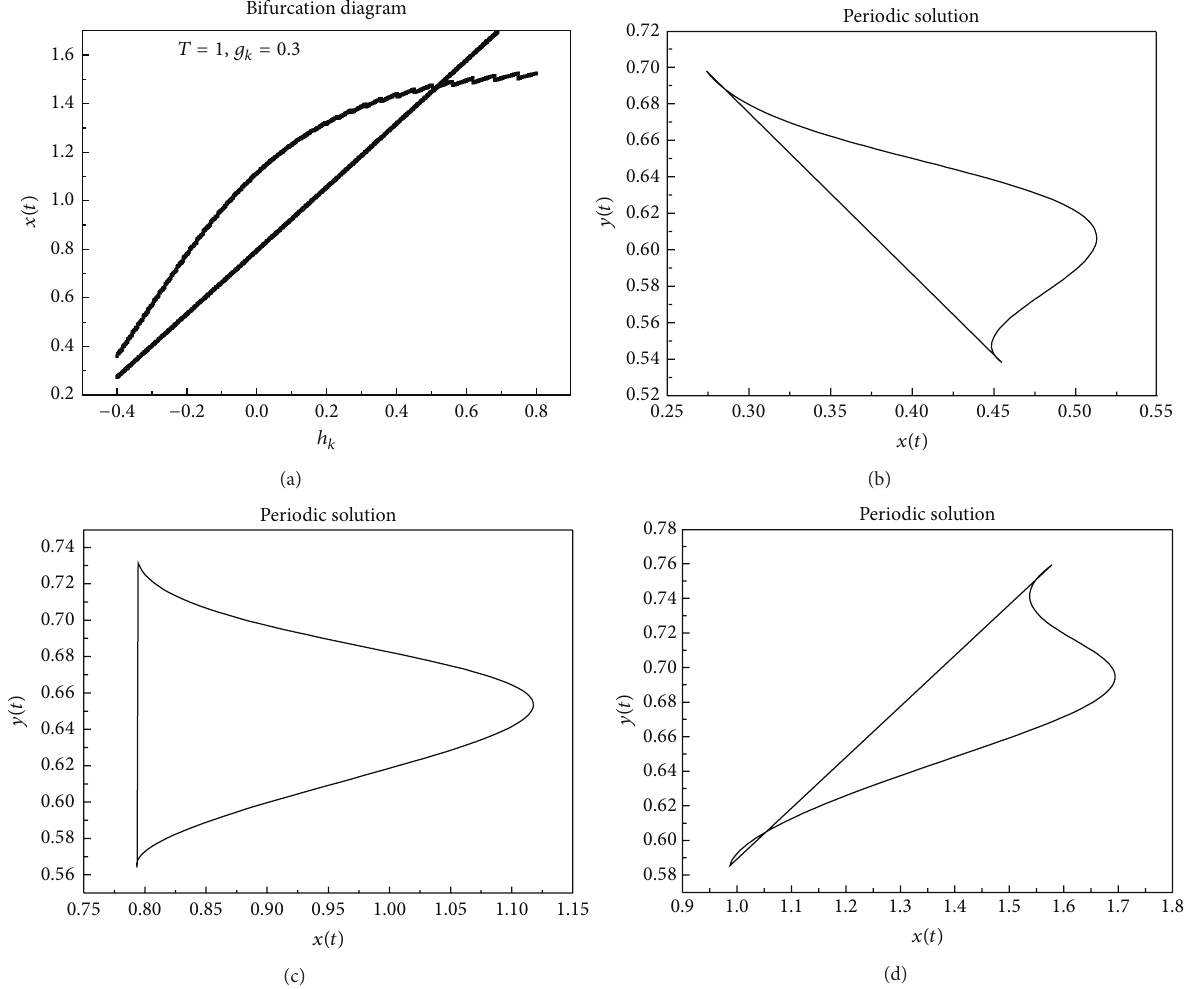
Figure 3: (a) Bifurcation diagram of ℎ 𝑘 when 𝑔 𝑘 is fixed at 0.3; (b)–(d) phase